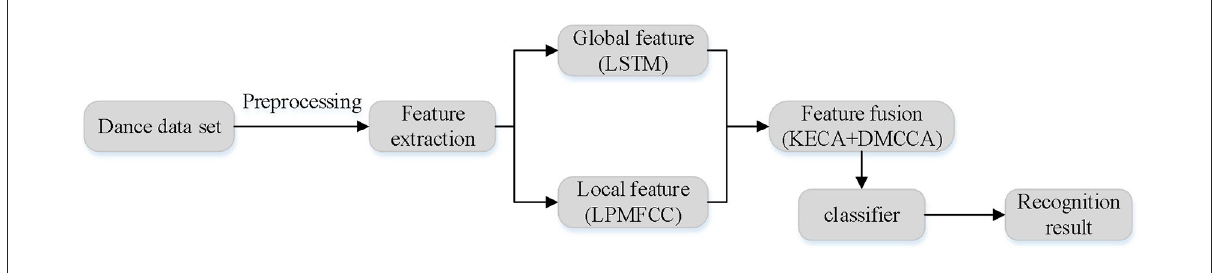
FIGURE1 Flow chart of proposed dance emotion